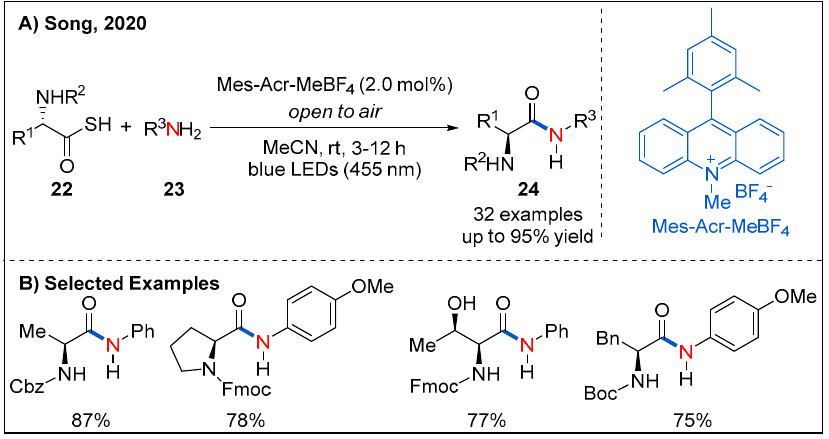
Figure 10. Visible light-induced amide bond formation from thioacids.